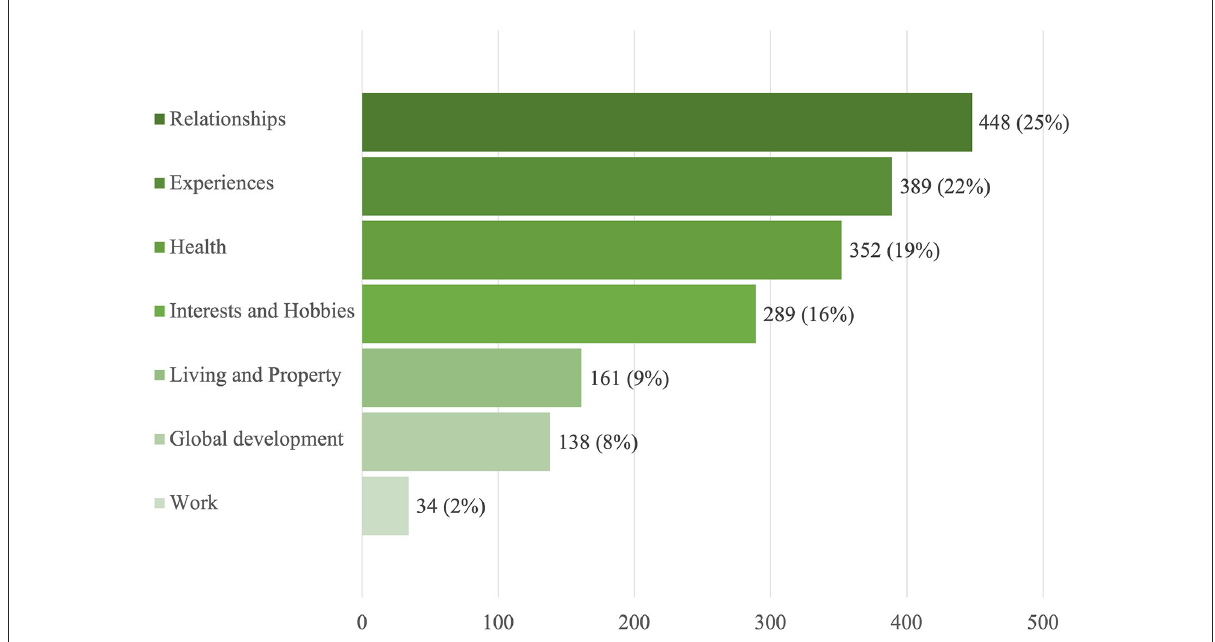
FIGURE1 What do you wish for in life: Number of mentions and percentages in each category.